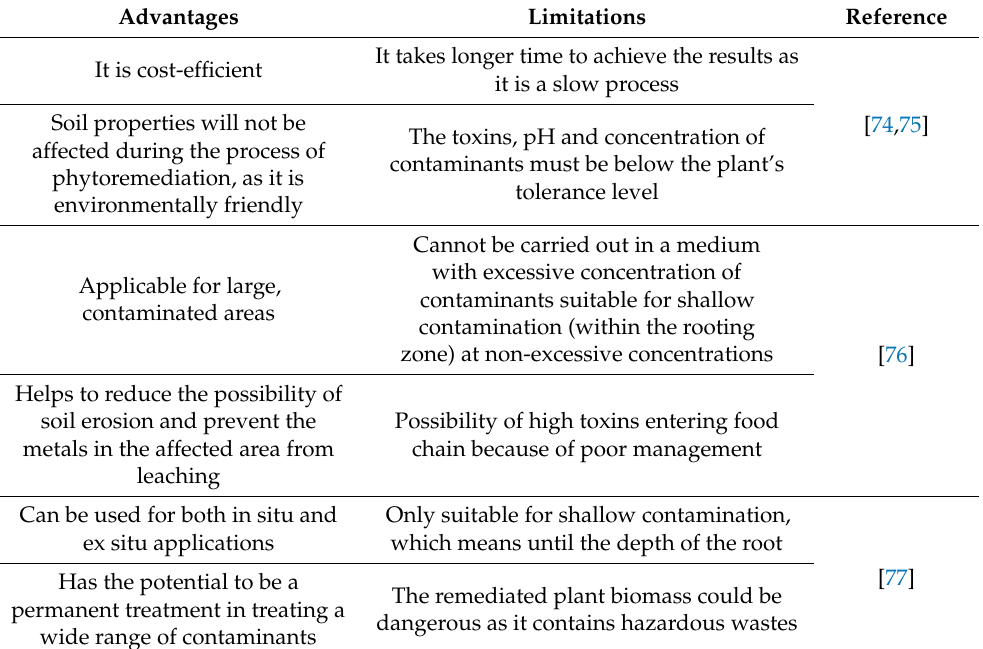
Table 4. The advantages and limitations of the phytoremediation